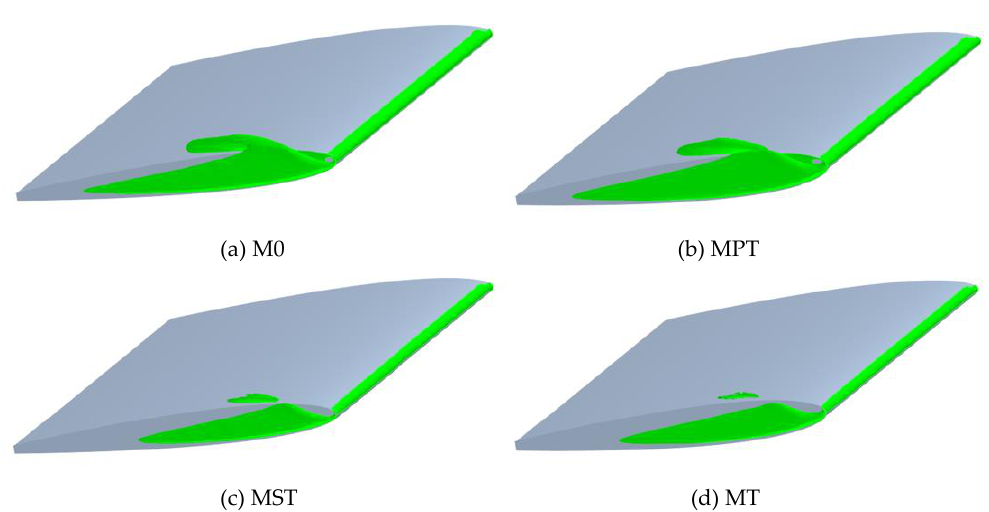
Figure 13. Isosurfaces showing Proudman AP sound sources at 50 dB.